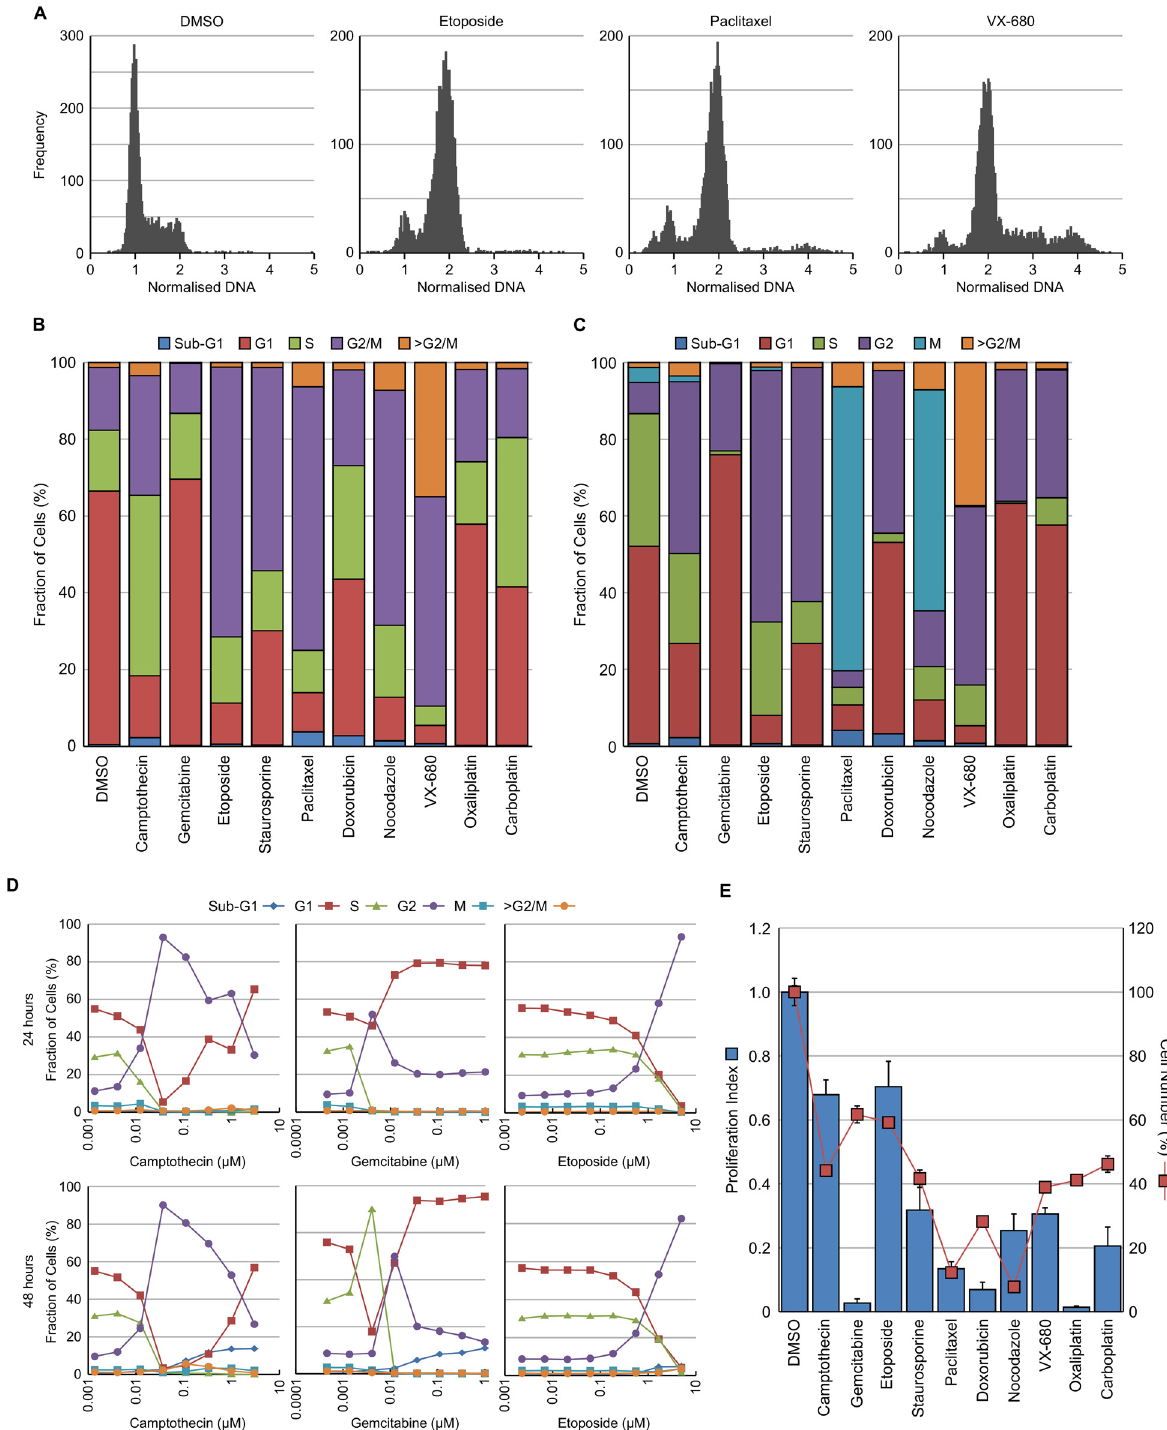
Fig 3. Validation of image analysis protocol. HT29 cells were treated with the indicated compound for 24 hour and then fixed and stained with Hoechst 33342, EdU and pHH3 (S10). (A) Example histograms following treatment with DMSO, etoposide, paclitaxel or VX680. Cell cycle distribution was determined using either DNA histogram analysis (B) or multiparametric analysis (C). (D) Time course and dose response of cell cycle changes determined using the multiparametric method for cells treated with camptothecin, gemcitabine or etoposide. (E) Proliferation index (EdU positive cells treated / EdU positive cells control) and cell number were determined from the images. Values are the average of 6 technical